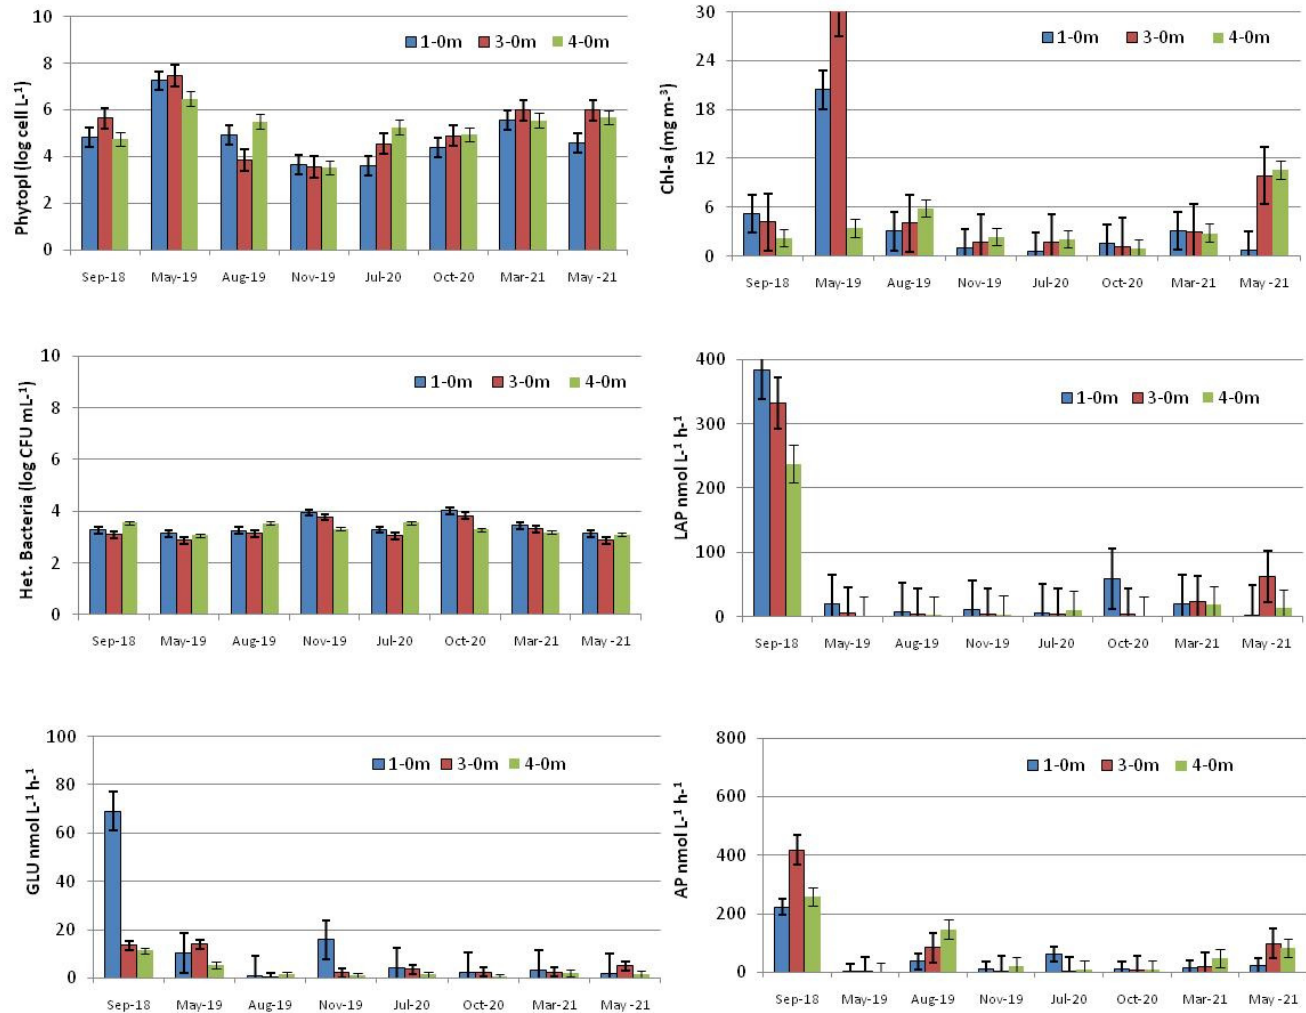
Figure 3. Seasonal trends of autotrophic abundance and biomass (as Chl a content) and heterotrophic bacterial abundance, together with microbial activity rates, observed at human-impacted stations (HIS, Stations 1, 3, 4).